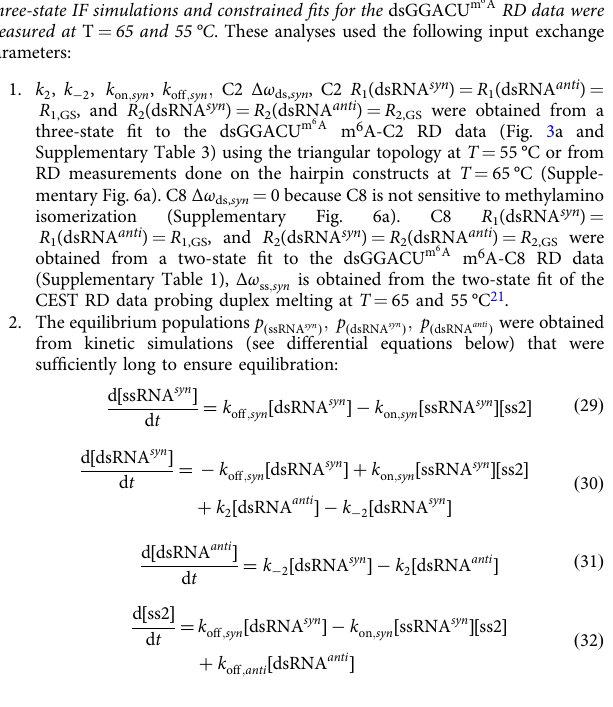
species) were allowed to fl oat by an amount determined by the uncertainty (1s.d.). When possible, global constrained three-state B – M fi ts were carried out on both m 6 A C8 and C2 CEST data (Fig. 2f). χ 2 red was calculated to assess the goodness of fi tting 18 . Three-state IF simulations and constrained fi ts for the dsGGACU m 6 A RD data were measured at T = 65 and 55 °C . These analyses used the following input exchange parameters: